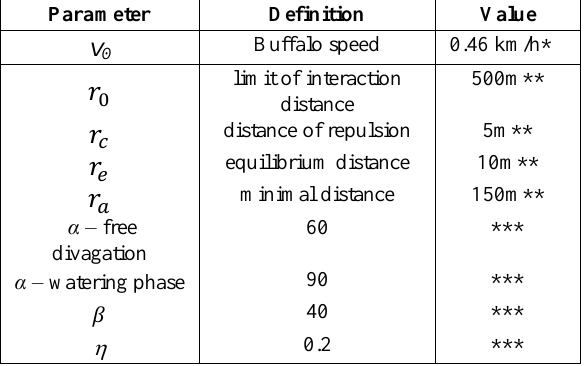
Table 1. Model parameters estimated from telemetry data (*), expert knowledge (**), or calibration